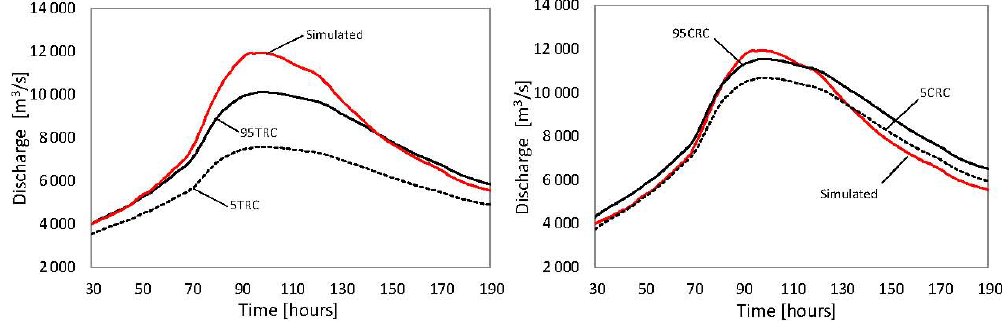
Fig. 9. Cremona cross-section and October 2000 flood: flow hydrograph simulated through the Piacenza-Pontelagoscuro model (red line); flow hydrographs retrieved from Traditional (left panel) and Constrained (right panel) percentile